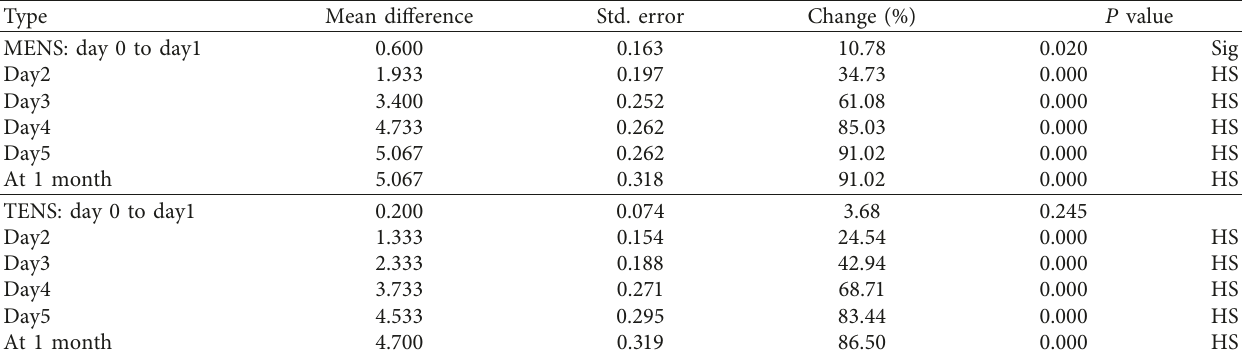
Table 4: Improvement in VAS in the study period between the TENS and MENS group (post hoc analysis by Bonferroni test; measure: MEASURE_1; parameter: